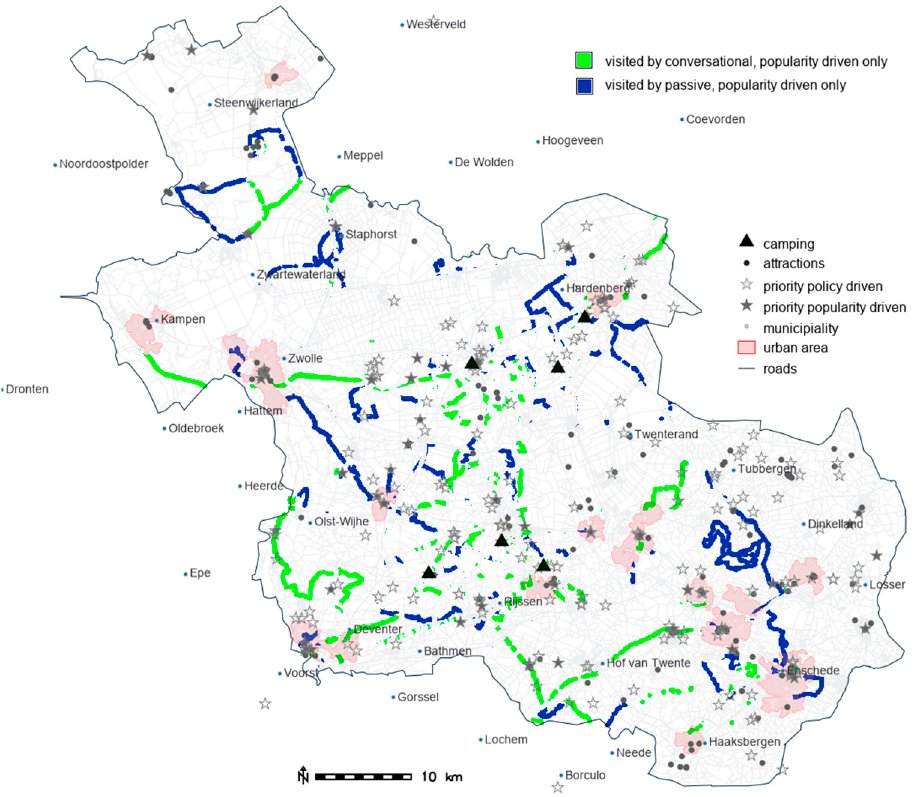
Figure 5. Locations visited exclusively by each of the 2 popularity-driven groups. Table 2. Coverage of Overijssel and its urban areas by each